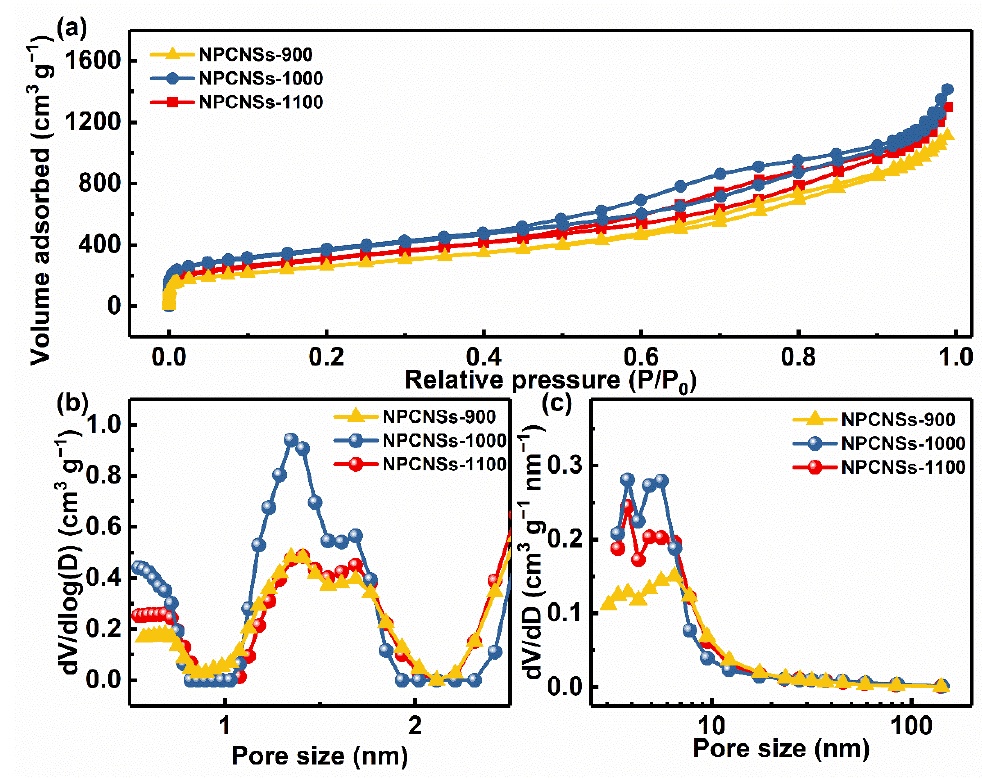
Figure 4. ( a ) N 2 ad-/desorption isotherms, ( b ) microporous, and ( c ) mesoporous diameter distribu- tion curves of NPCNSs-900, NPCNSs-1000, and